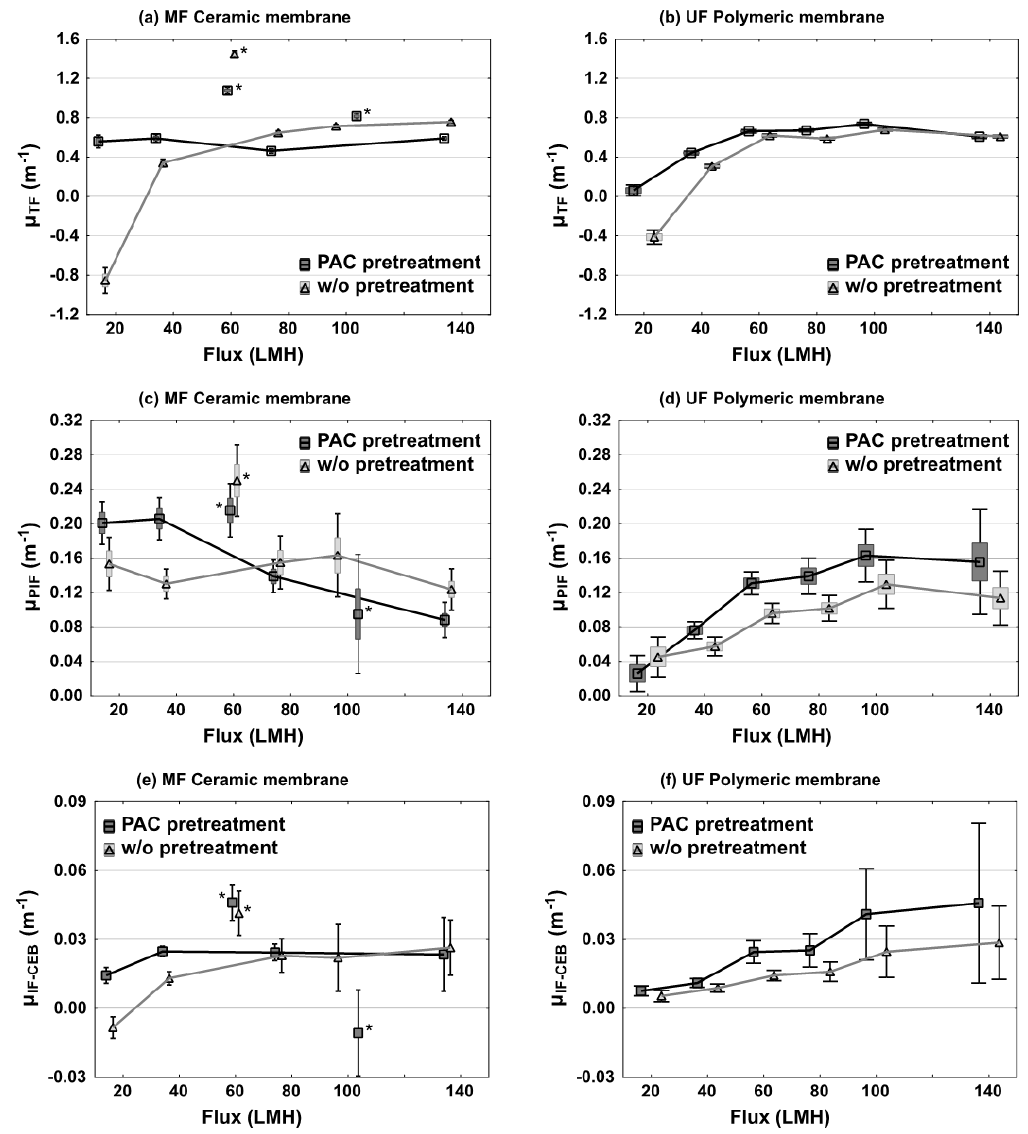
Figure 5. Fouling coefficients of MF ceramic membranes ( a , c , e ) and UF polymeric membranes ( b , d , f ) fed with and without PAC pretreated water (black and grey distributions respectively). Markers indicate arithmetic means, boxes represent standard errors and whiskers illustrate the 95% confidence interval. * indicate the three outlier conditions due to improper CIP.